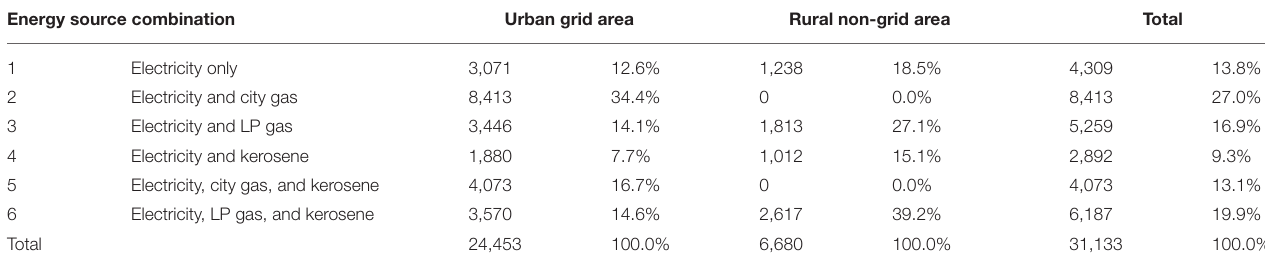
TABLE 1 | Household choice of energy source combinations. Energy source